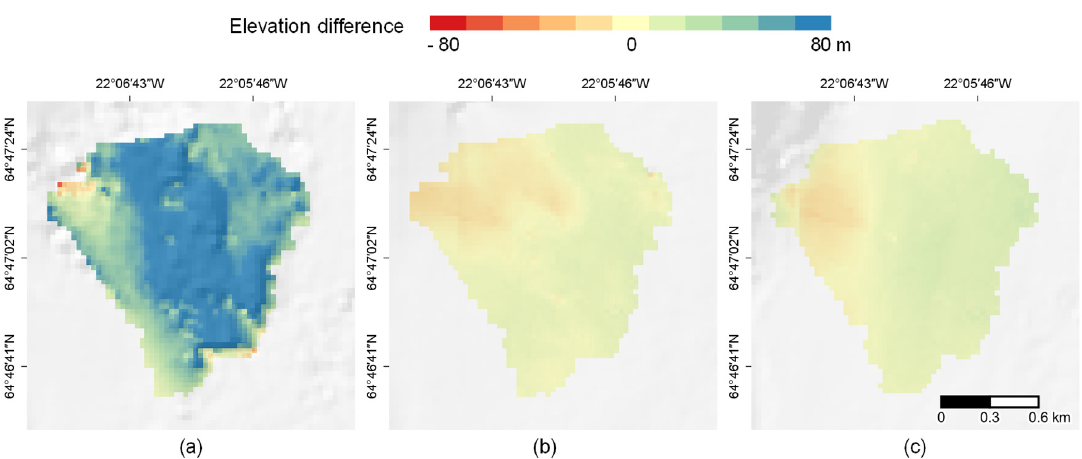
Figure 8. Elevation differences of the three Sentinel-1 DEMs compared to the ArcticDEM for the landslide deposition area used for calculation of the landslide volume. ( a ) elevation differences of DEM from track 16 (11 July 2018 and 17 July 2018); ( b ) elevation differences of DEM from track 118 (5 August 2018 and 11 August 2018); ( c ) elevation differences of DEM from track 155 (4 July 2019 and 10 July 2019). The respective hillshade derived from the Sentinel-1 DEMs was overlaid for each result.